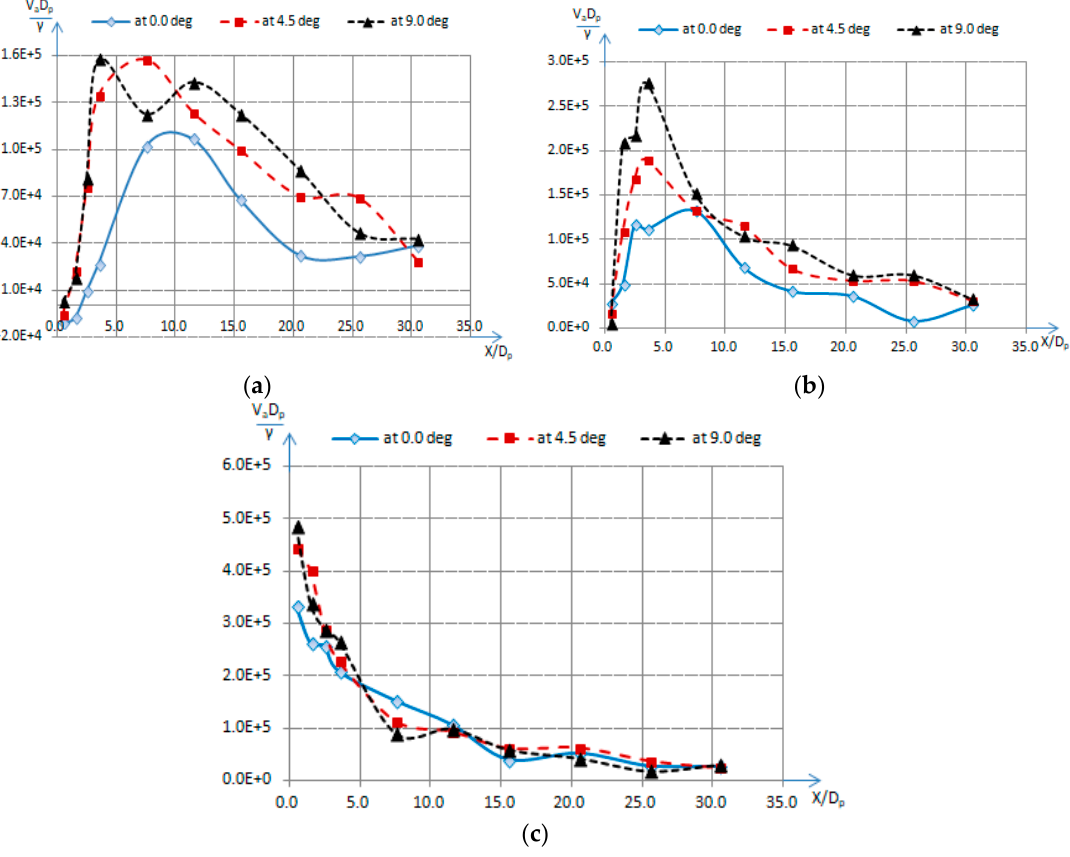
Figure 3. ( a ) Mean axial flow velocity along x/D p at y/D p = 0 and d = 0.25D p for different ‘ θ ’; ( b ) mean axial flow velocity along x/D p at y/D p = 0 and d = 0.55D p for different ‘ θ ’; ( c ) mean axial flow velocity along x/D p at y/D p = 0 and d = 1.05D p for different ‘ θ ’. Case #3: The individual effect of propeller submergence (H) on the mean axial flow velocity (V a ) along x/D p at the center of the wake field (y/D p = 0) is illustrated in Figure 4a–c for the three different depths of measurements: 0.25D p , 0.55D p and 1.05D p , respectively. These plots illustrate that the characteristics of the mean axial velocity along x/D p with ‘H’ also largely depend on the depth. In general, at shallow depth, the axial velocity increases with decreasing ‘H’, and at deeper depth the mean axial velocity is not significantly affected in the downstream and shows mixed effects in the region near the propeller.